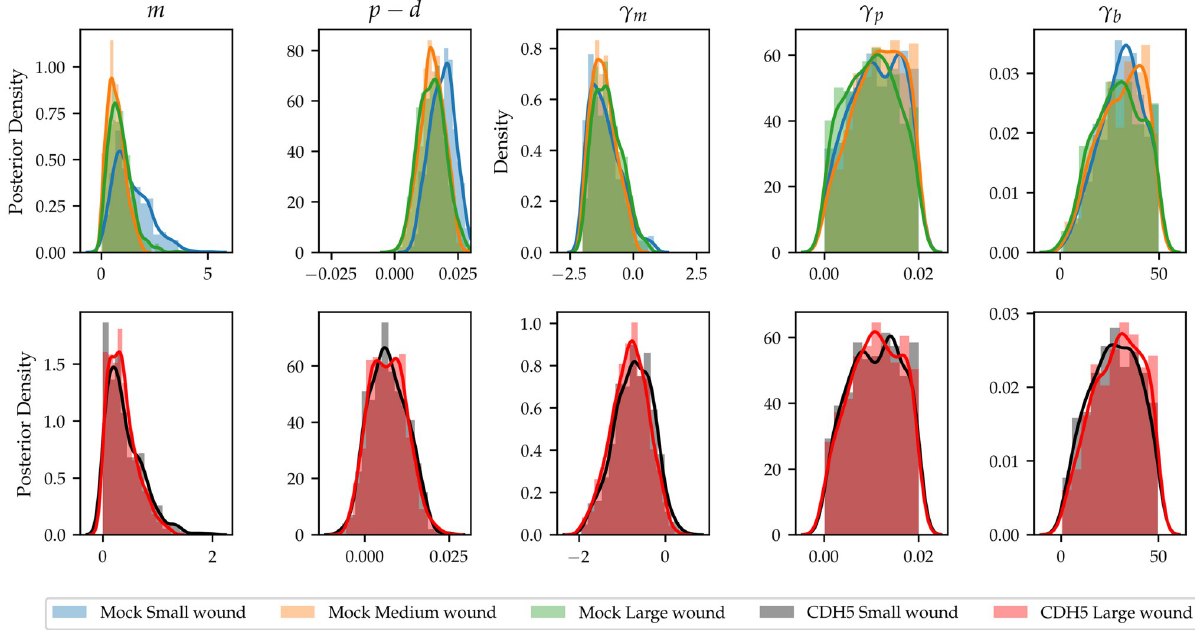
Fig 5. Posterior distributions for model parameters when inference is carried out on subsets of the data based on wound size. Top row: Mock experiments, three different wound size categories are identified—small (blue, < 2.43mm 2 ), middle (orange, 2.43mm 2 − 2.70mm 2 ), and large (green, > 2.70mm 2 ). Bottom row: CDH5 knockdown, two different wound size categories are identified—small (black, < 2.25mm 2 ) and large (red, > 2.25mm 2